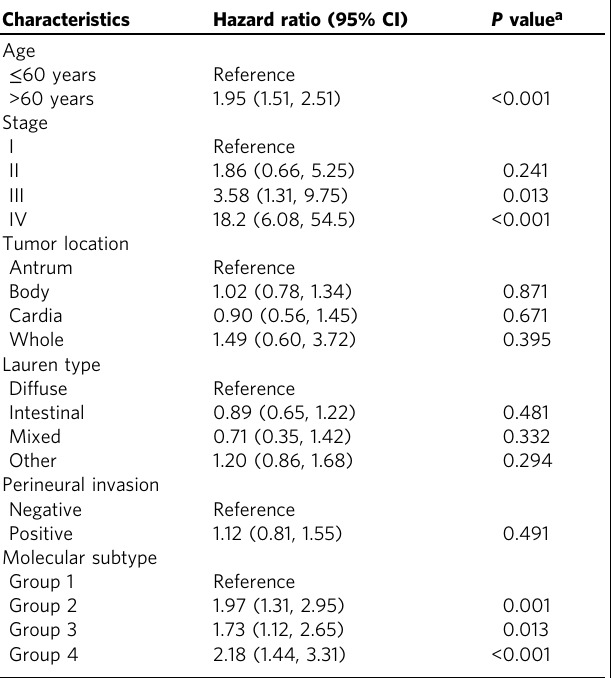
Table 2 Multivariable analysis of the Yonsei cohort.